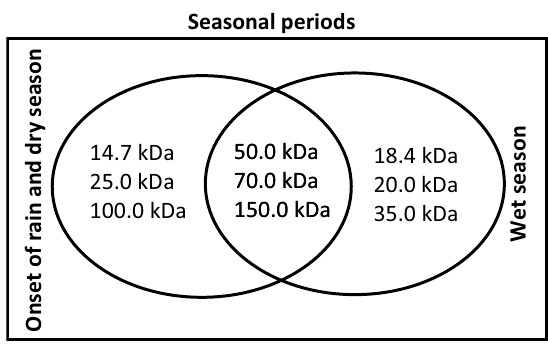
Fig. 3 Common protein bands of the study honeybees during the period of onset of rain, wet season and dry